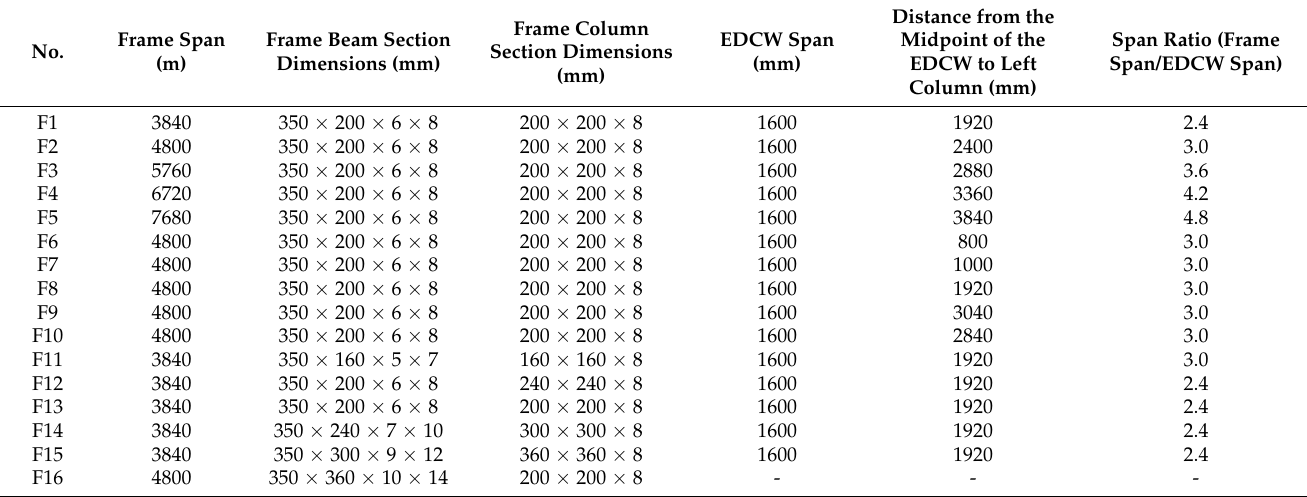
Table 4. Parameters of the steel frame